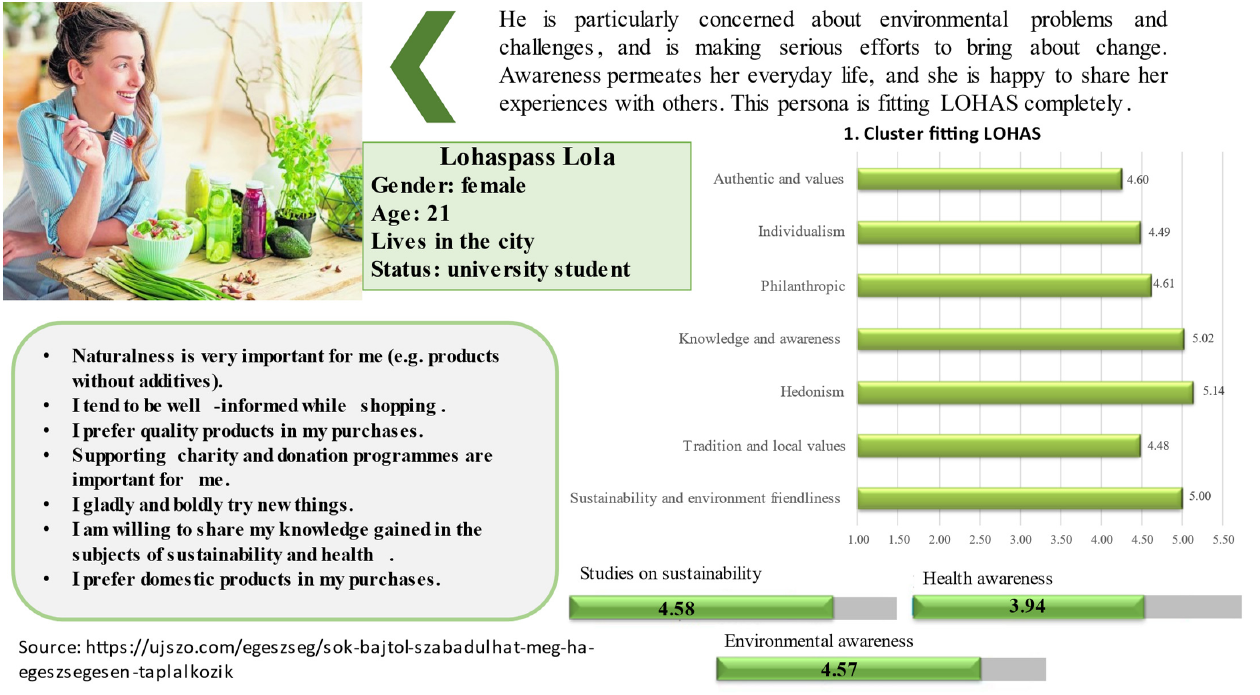
Figure 2. ‘Lohaspass’—the persona that best fits the LOHAS model. Source: Authors’ own compilation based on the results of cluster analysis, 2022.